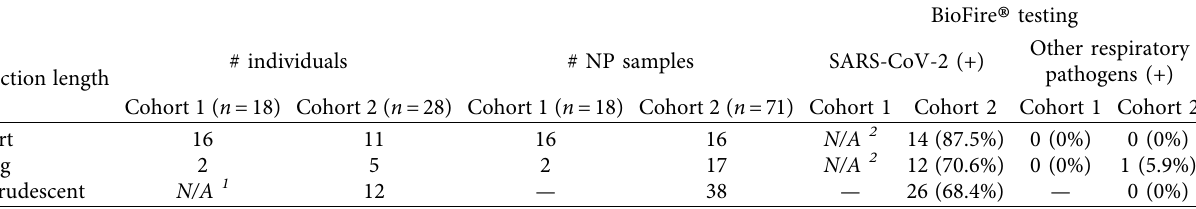
Table 3: COVID-19 infection duration and concurrent respiratory infection.